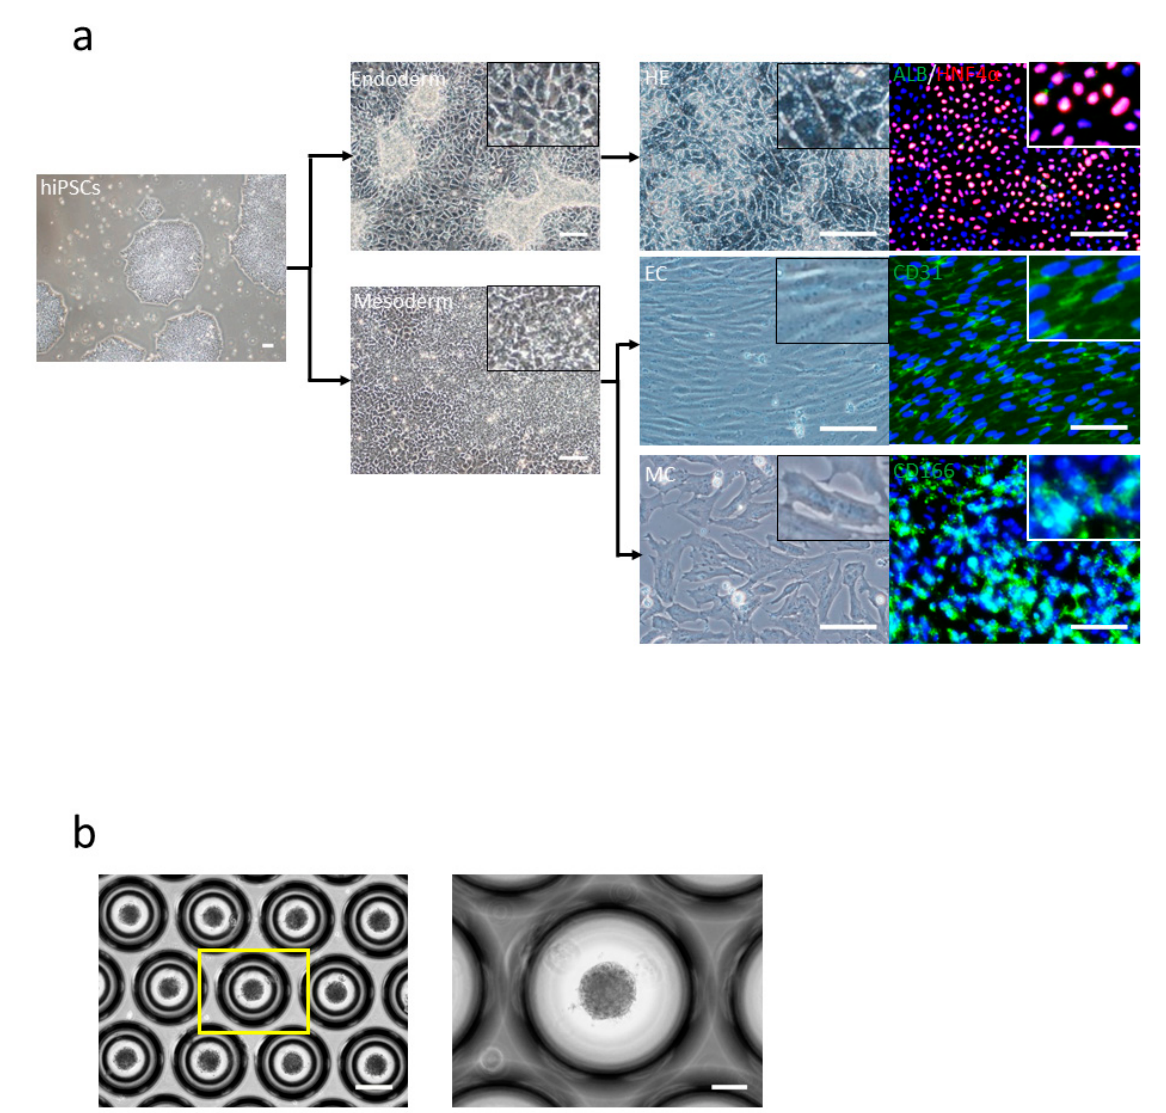
Figure 1. Human-induced pluripotent stem cell (hiPSC)-derived liver bud generation. ( a ) hiPSCs were differentiated to individual cells: hepatic endoderm (HE) (right-top) human albumin (ALB) (green) and HNF4 α (red), endothelial cells (EC) (right-middle) CD31 (green), and mesenchymal cells (MC) (right-bottom) CD166 (green) and 4 ′ ,6-diamidino-2-phenylindole (DAPI) (blue). Scale bar: 100µm. ( b ) Day 1 morphology of the liver bud is seen. Scale bar: 100µm.